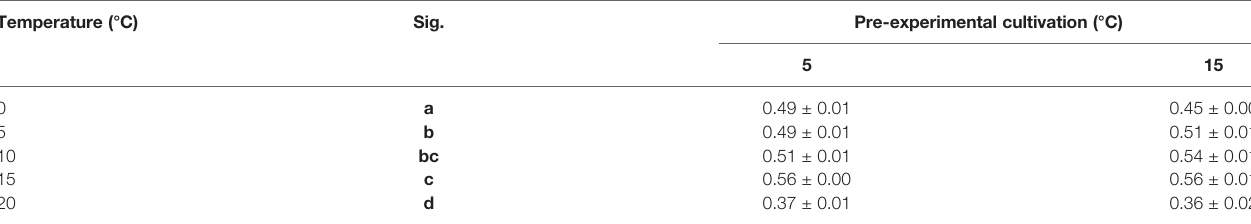
TABLE 5 | Photosynthetic optimum quantum yield (F v /F m ) of juvenile Laminaria digitata sporophytes following pre-experimental cultivation of parental gametophytes and sporophytes growth for 2 weeks in a temperature gradient (mean ± standard deviation, n = 5). Temperature (°C) Sig.